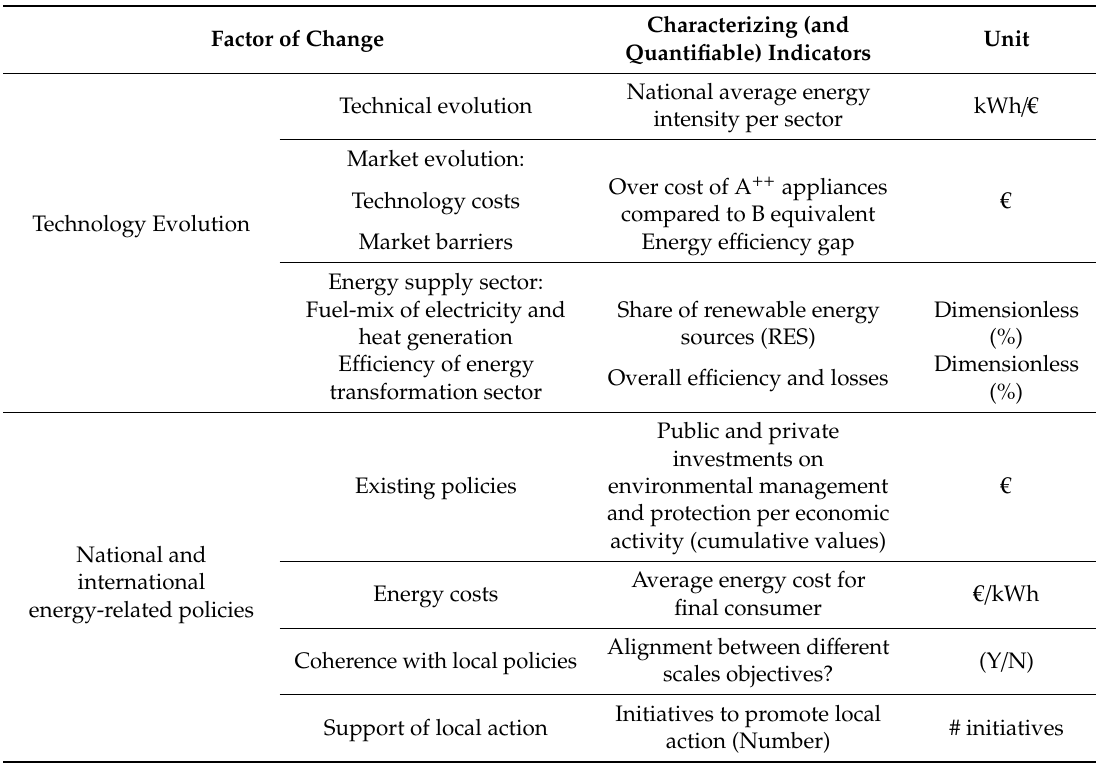
Table 6. Factors of change related to higher-level governance framework with corresponding indicators. Characterizing Factor of Change